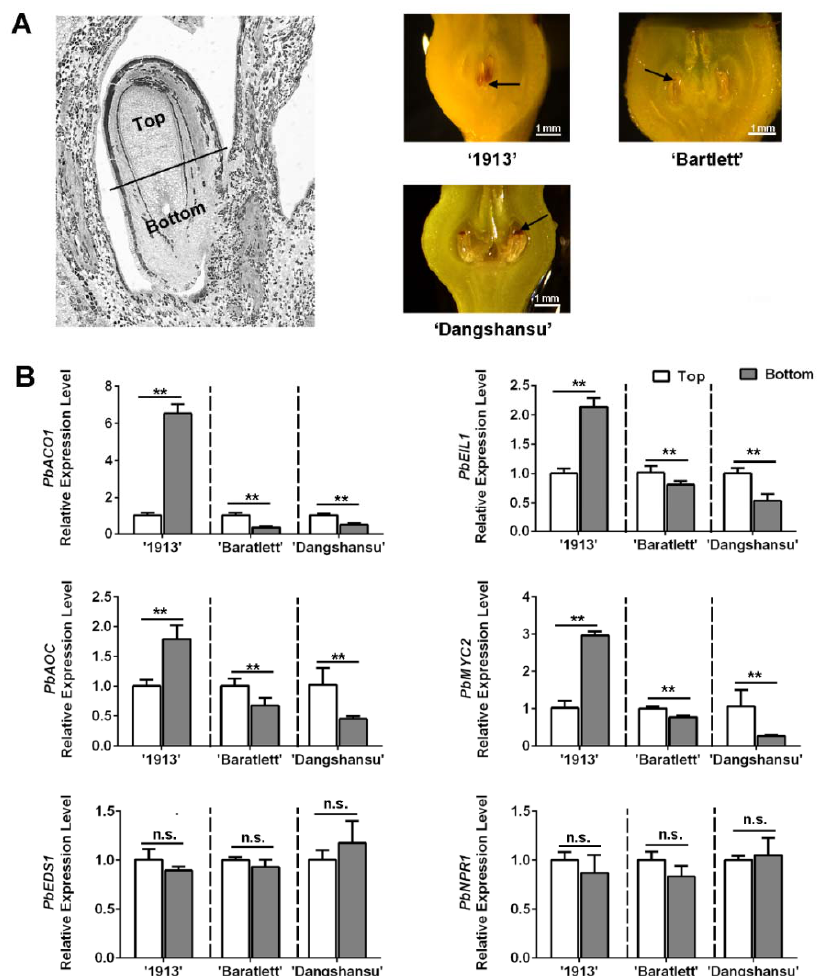
Figure 4. The distribution of JA, SA and ethylene in ovules of seedless pear ‘1913’ and seeded pear ‘Bartlett’ and ‘Dangshansu’ is different. ( A ) The left pear ovule is divided into two parts, the top (the abaxial-funiculus tissue) and bottom (the adaxial-funiculus tissue). Right exhibits that the unpollinated ovules of ‘1913’, ‘Bartlett’ and ‘Dangshansu’ at 16 DAT show different locations of ovule cell death. The black arrows point to areas of significant ovule cell death. ( B ) The expression level of ethylene, JA and SA pathway-related genes on the top and bottom ovule tissue from the seeded and seedless pear. The samples were collected from unpollinated ovules at 16 DAT. The expression level of each gene in the top sample was normalized to 1.0. The data are mean ± SD of three biological replicates. Error bars represent the standard deviation. Asterisks indicate significant difference at ** p < 0.01 (Student’s t -test). n.s., no significance.